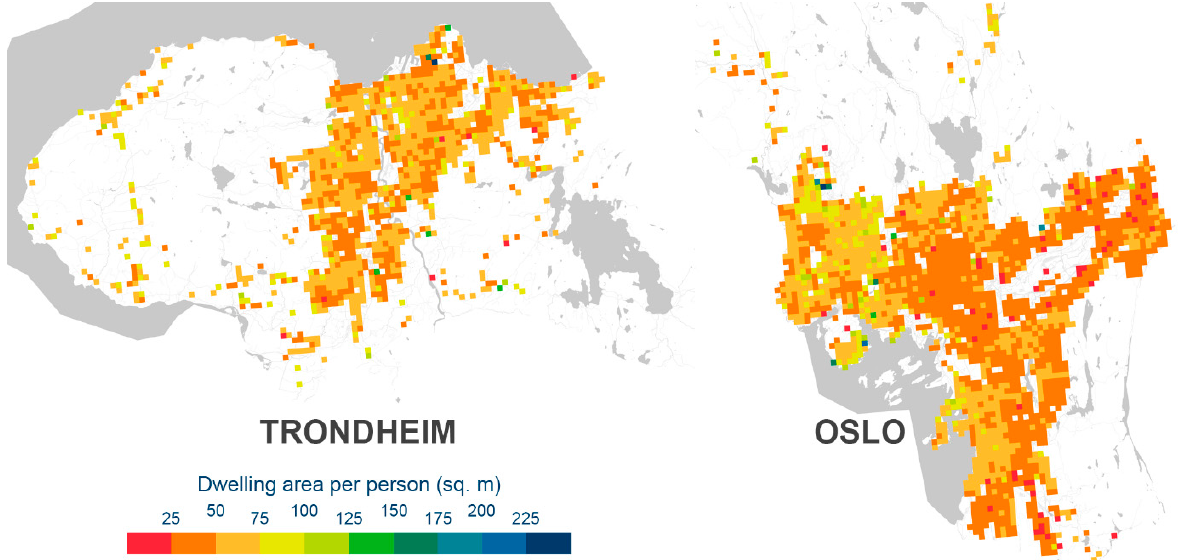
Figure 3. Dwelling area (GIA in m 2 ) per person for each grid cell in Trondheim and Oslo.